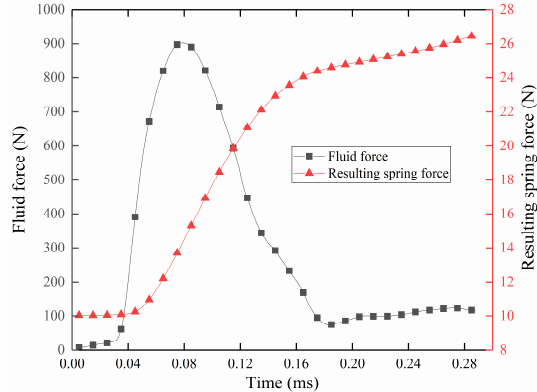
Figure 13. Fluid force and resulting spring force during the opening process.